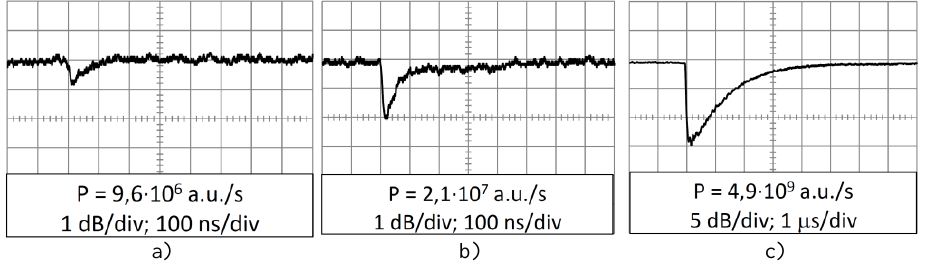
Fig. 7. Waveforms of the gain ionizing response under irradiation at three P values: 9.6∙10 6 a.u./s (a); 2.1∙10 7 a.u./s (b); 4.9∙10 9 a.u./s